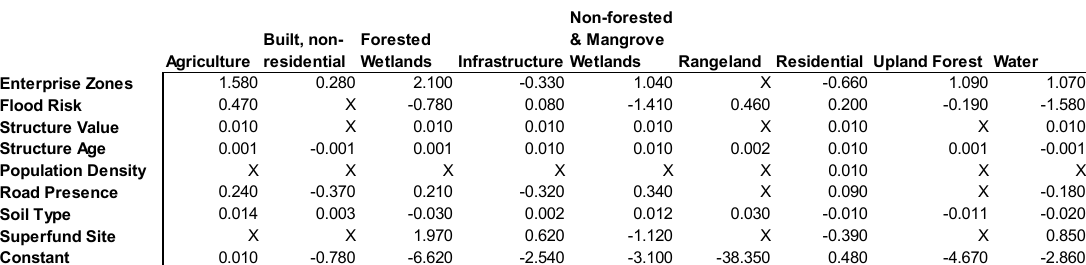
Figure A1. Statistically significant beta coefficients of driving factors for each LULC class. If a coefficient is absent (X) it was not statistically significant at α = 0.05.